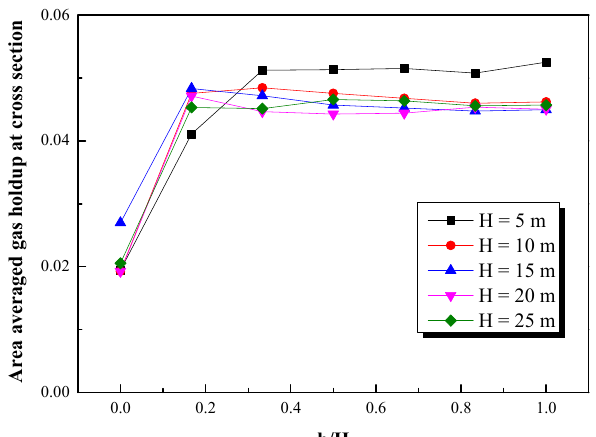
Figure 7. Area-averaged gas holdup at different cross sections for various total column heights with U Gr of 0.0389 m/s.